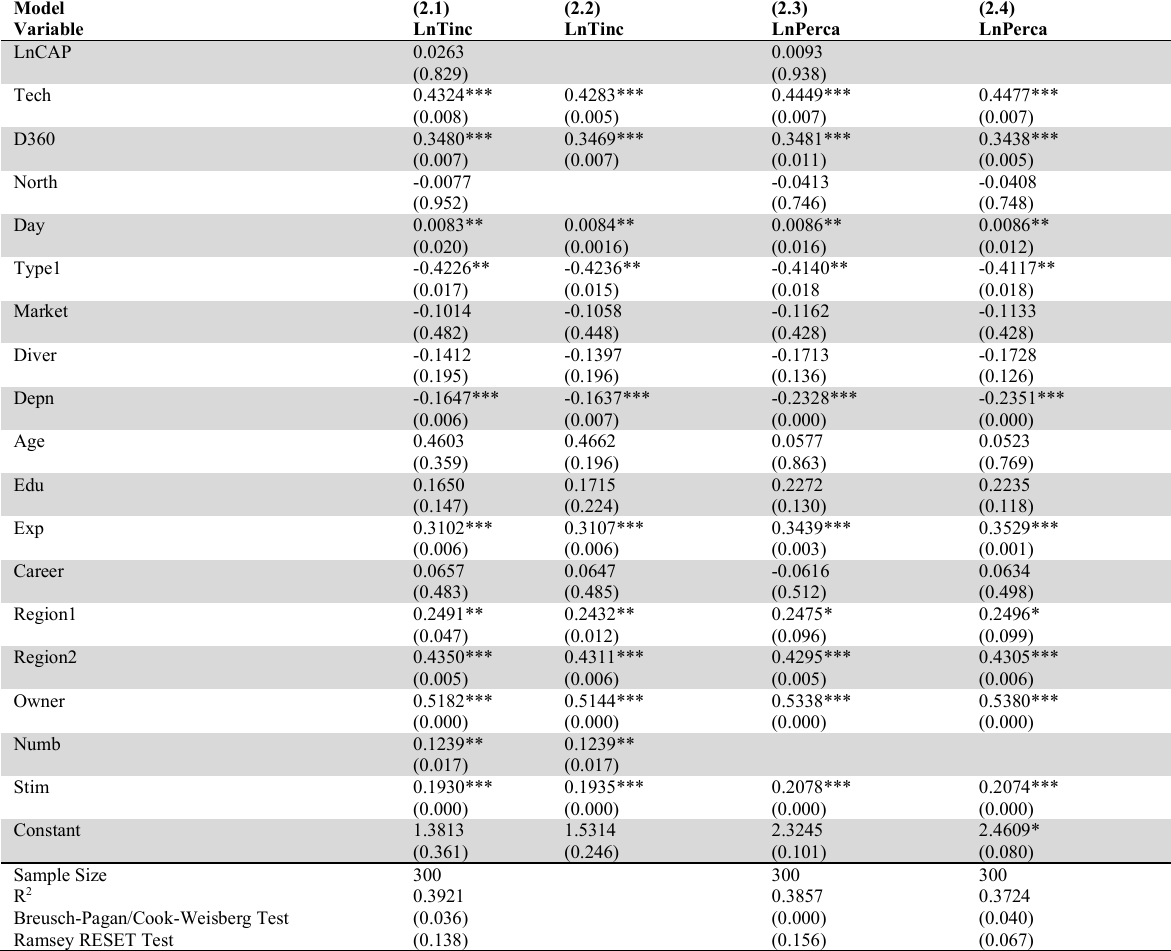
Factors Affecting Offshore Income of Fishing Households in the South Central Coast : Model with Intercept Dummies